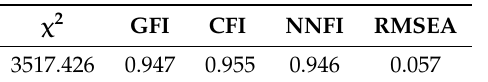
Table 5. Fit indices of structural model.